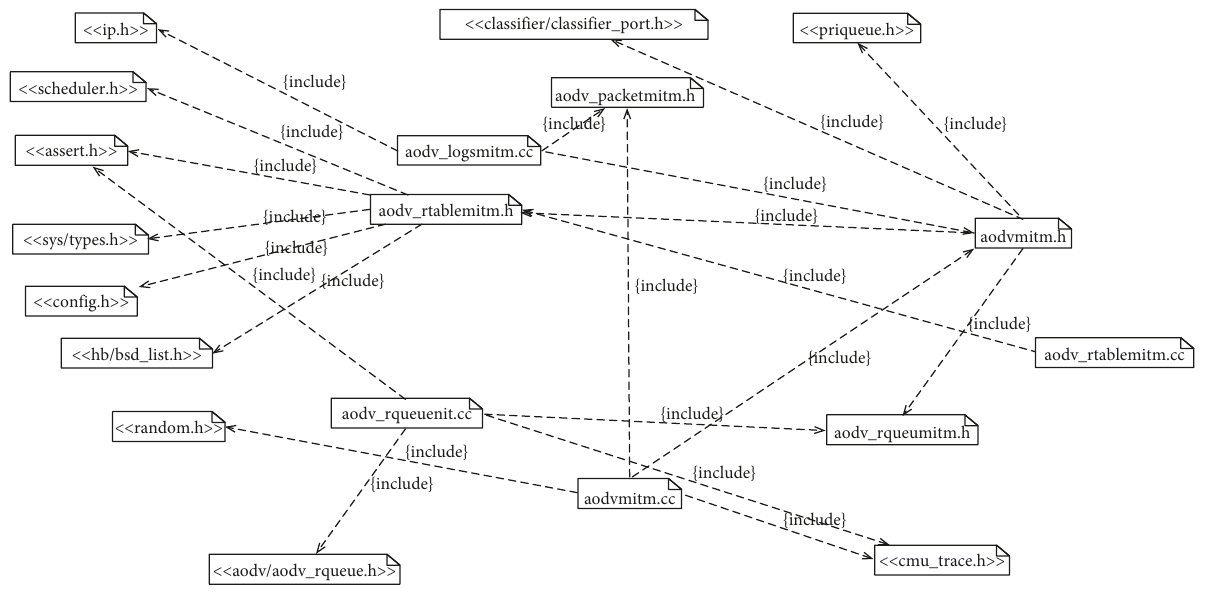
Figure 6: Component diagram for aodvmitm